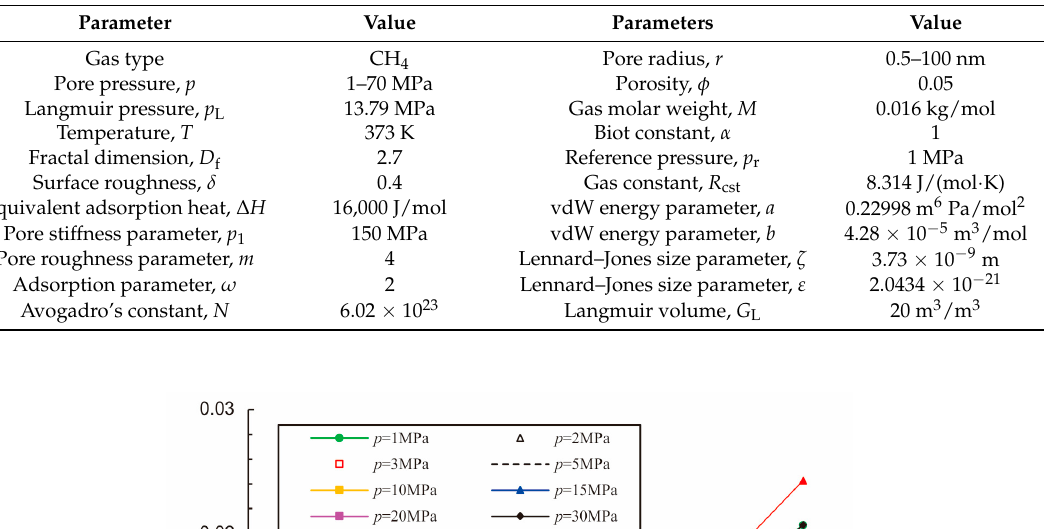
Table 6. Input parameters of gas and formation for model analysis.